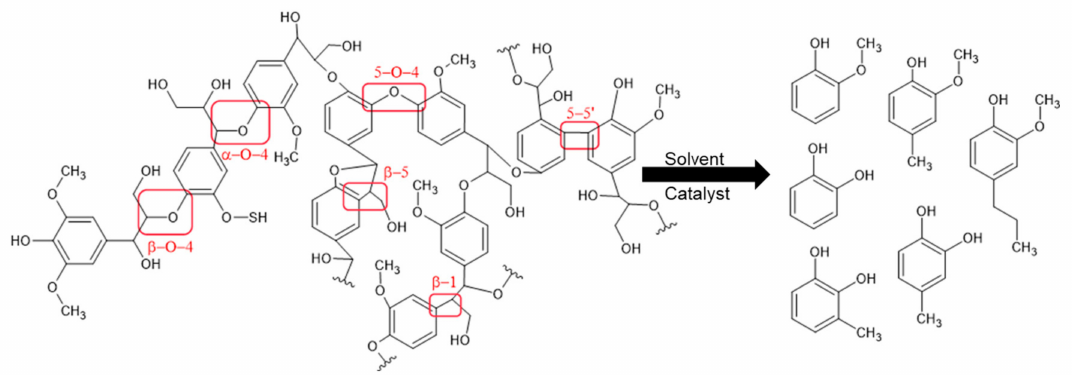
Figure 4. Controlling factors of the solvolysis reaction and their interactions, mediated by temperature, pressure and concentration.